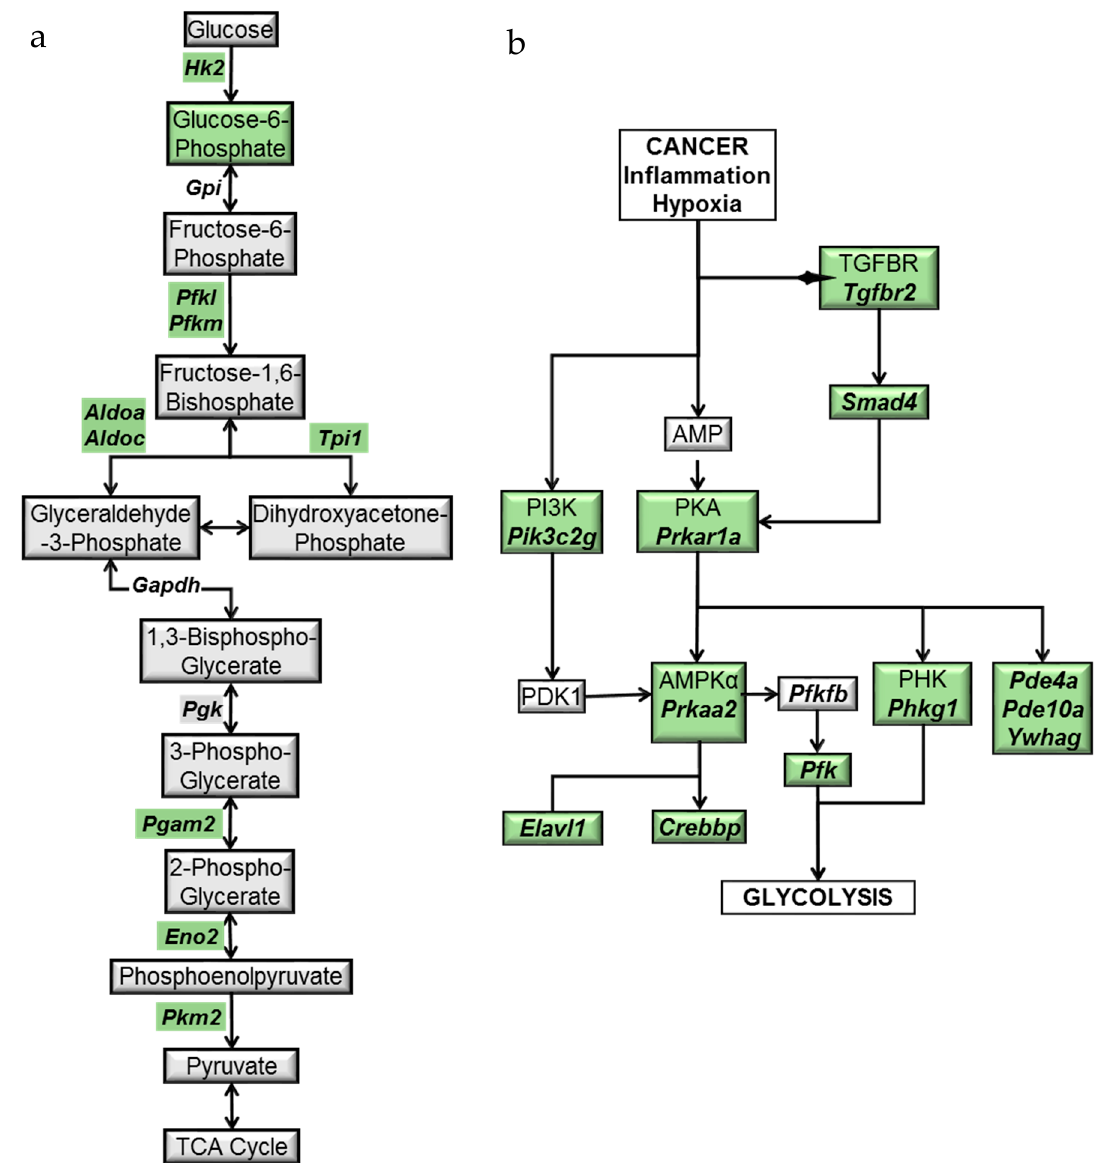
Figure 4. Model of the ( a ) glycolysis and ( b ) PKA-AMPK pathway genes and metabolites modulated by dietary BRBs during oral carcinogenesis. Downregulated genes and metabolites are shown in green.